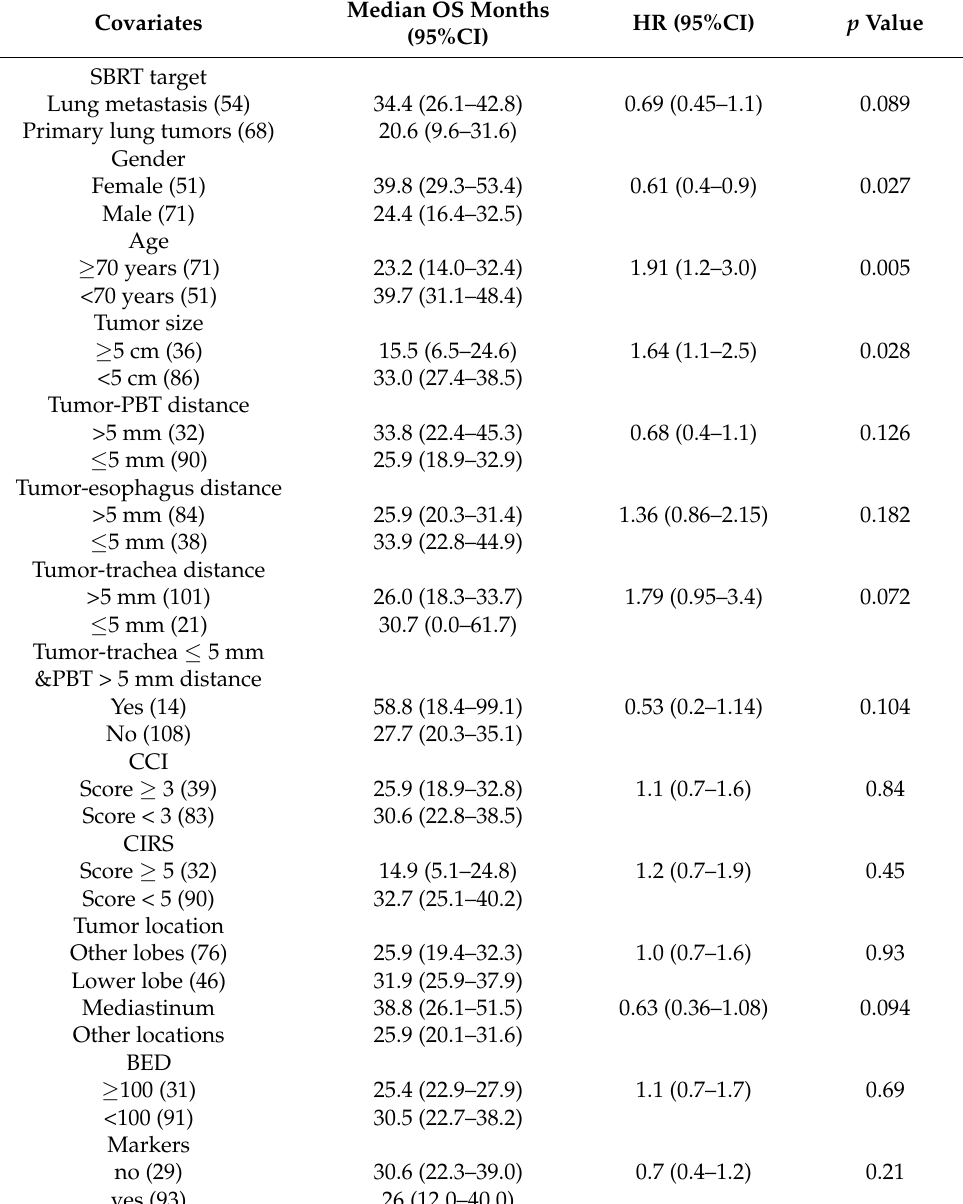
Table 3. Prognostic factors at univariate